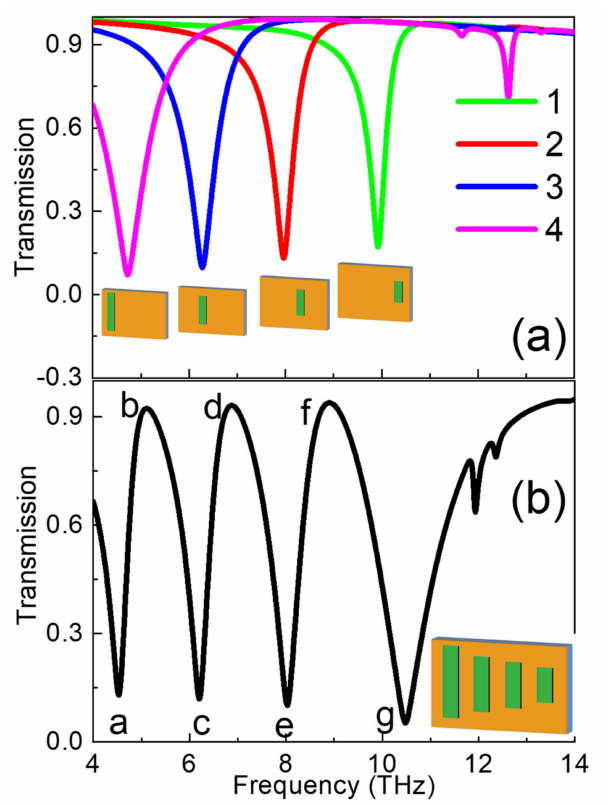
Figure 7. ( a ) Compared transmission spectra with different length graphene strips and ( b ) the whole structure.